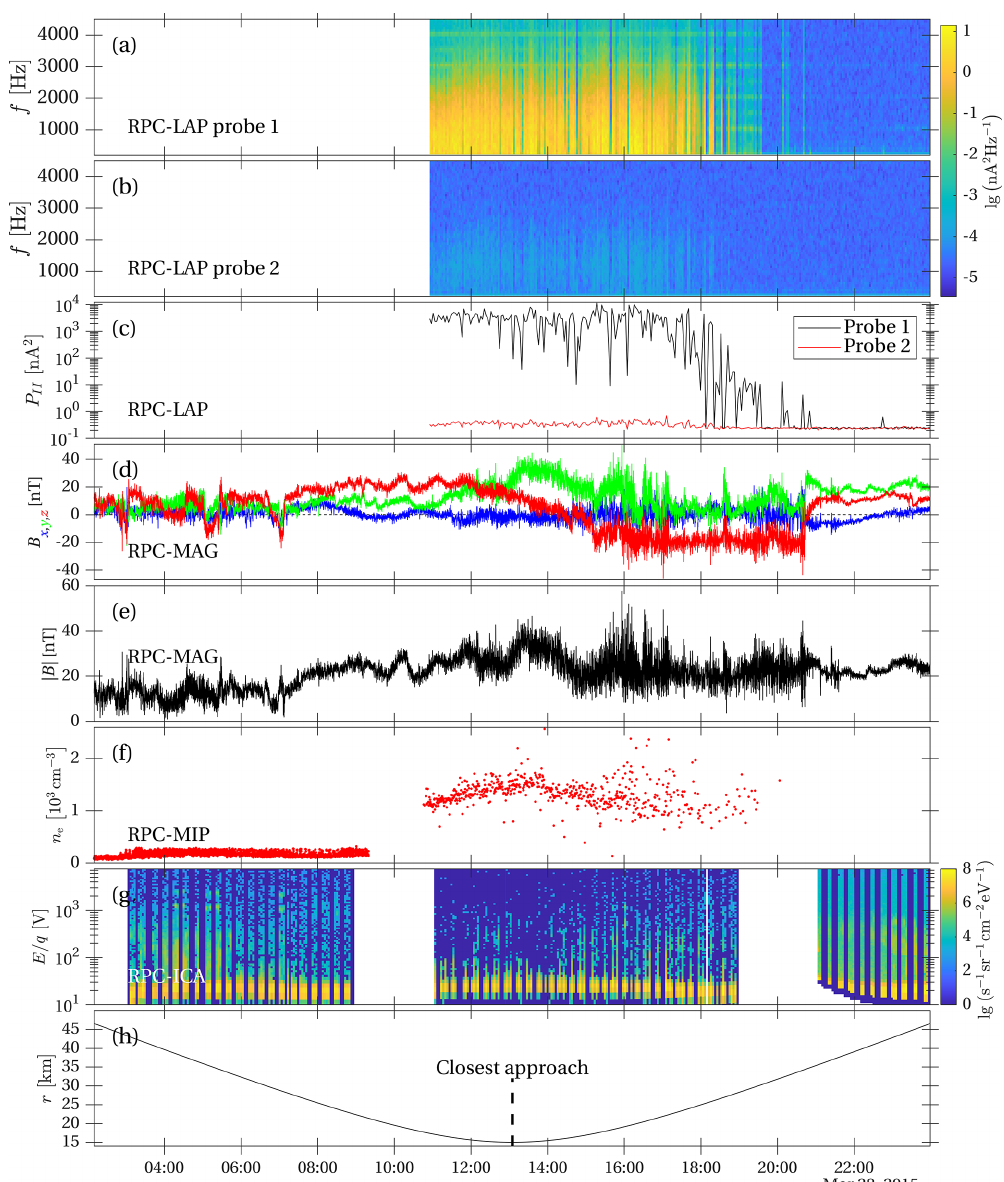
Figure 2. Rosetta observations during the close flyby of comet 67P/Churyumov–Gerasimenko on 28 March 2015. (a) Power spectral density of RPC-LAP probe 1 in the frequency range 200Hz < f < 4 . 5kHz. (b) Power spectral density of RPC-LAP probe 2 in the same frequency range. (c) The power spectral density of probes 1 and 2 integrated from 200Hz to the Nyquist frequency of 9375Hz. RPC-LAP probe 1 was biased to + 30V, and probe 2 was biased to − 30V with respect to the spacecraft potential. (d) B x (blue), B y (green), and B z (red) components of the magnetic flux density measured by RPC-MAG. (e) The magnitude of the magnetic flux density. (f) The plasma density derived from RPC-MIP data. (g) Ion energy spectrum observed by RPC-ICA summed over all angles and mass channels. (h) Cometocentric distance of the Rosetta